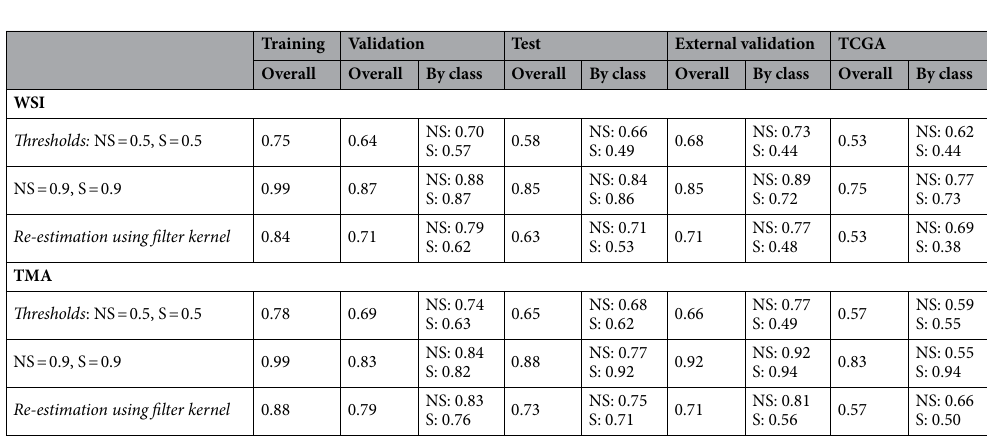
Table 2. Accuracy achieved by the different strategies at tile